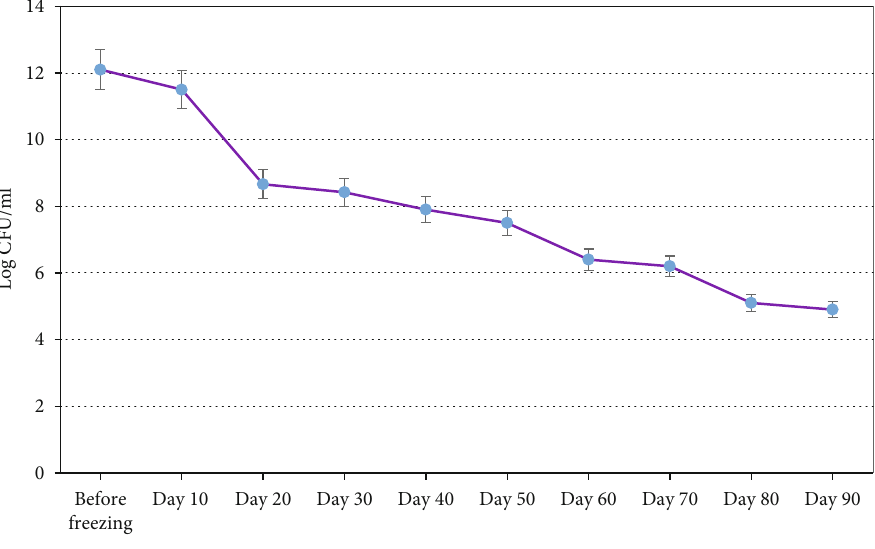
Figure 6: Bacterial viability results for r- L. lactis NZ1330 in ice cream produced within 90